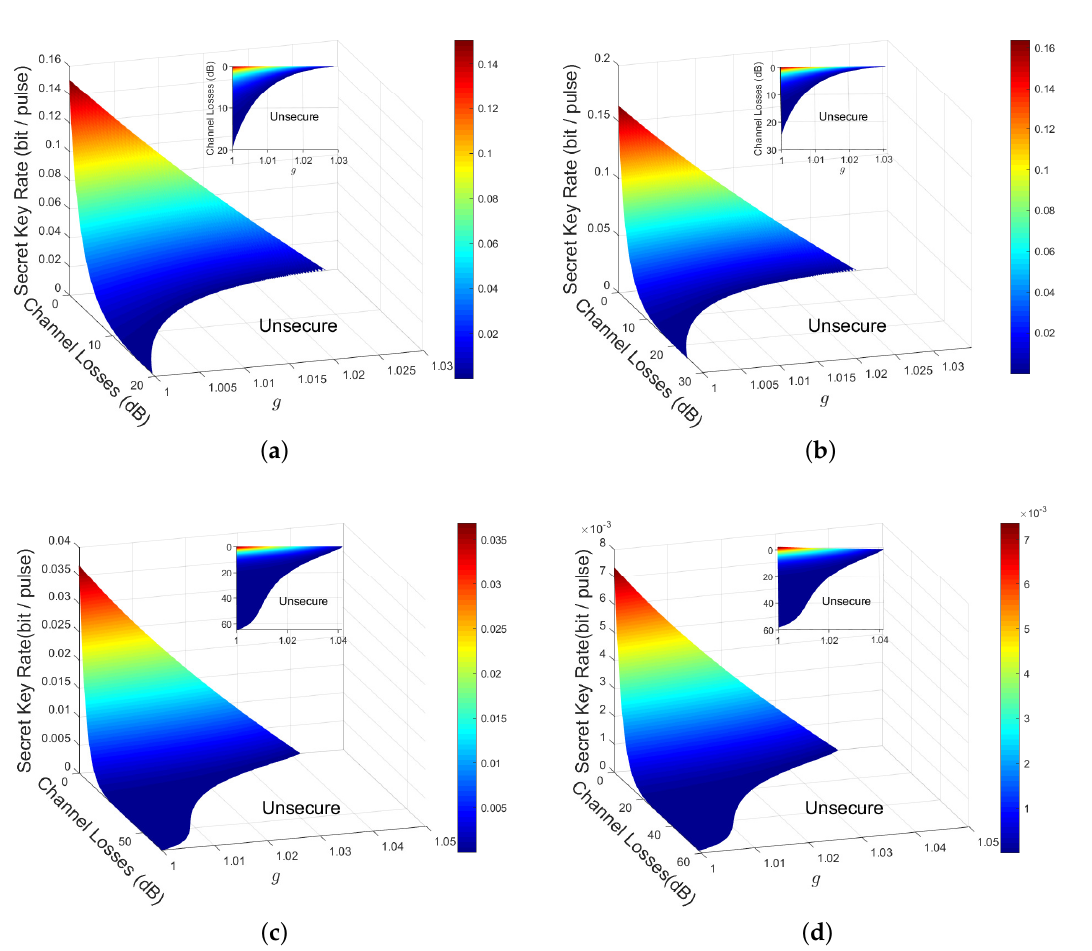
Figure 5. The secret key rate of plug-and-play DM-CVQKD of ( a ) PP 4-state DM-CVQKD protocol, ( b ) PP 8-state DM-CVQKD protocol, ( c ) 1-PS PP 4-state DM-CVQKD protocol and ( d ) 2-PS PP 4-state DM-CVQKD protocol. The modulation variance V M = 0.5, the channel excess noise ε = 0.01, and the reconciliation effiency β = 0.95.